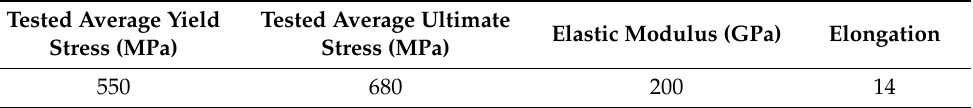
Table 3. Technical information of steel.